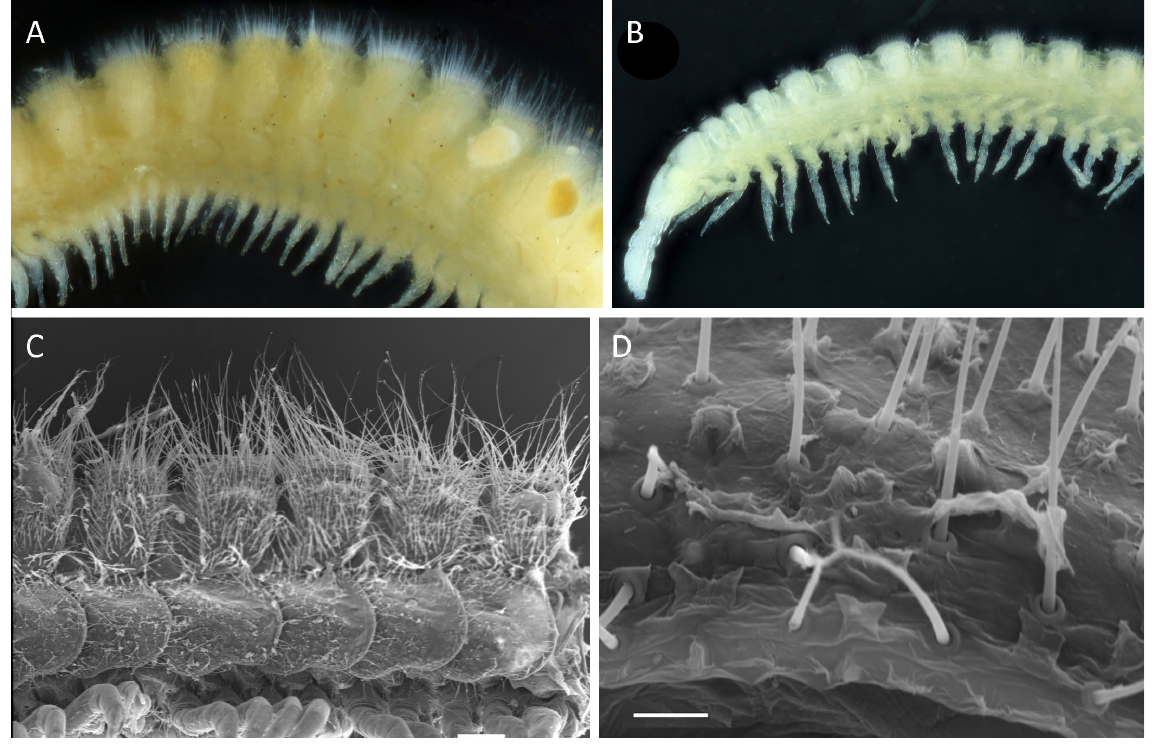
Fig. 5. Siphonophora setaepromissa sp. nov., non-type specimens. A . Mid-body rings of male with long setae, body width approximately 1 mm. B . Midbody rings of male with short setae, body width approximately 1 mm. C . SEM showing long setae in male. D . Limbus of female showing anchor-shaped tubercles. Scale bars: C = 100 µm; D = 10